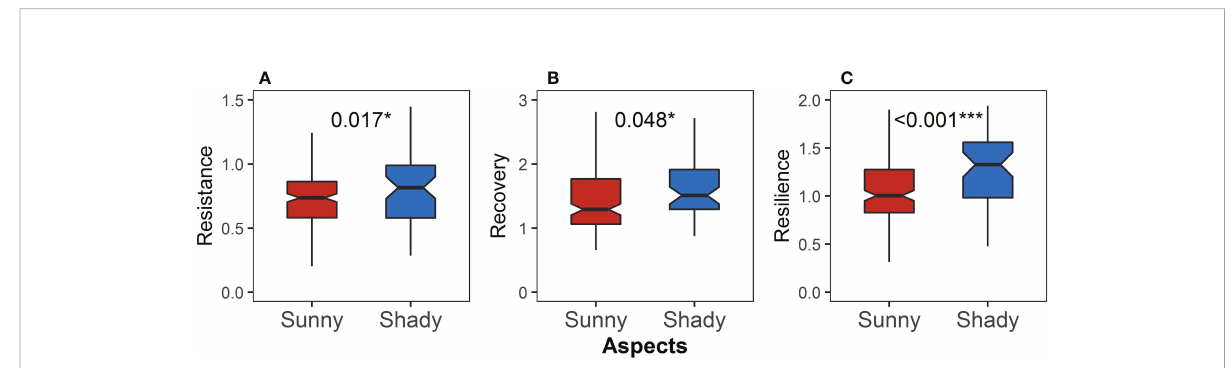
FIGURE 9 Differences in (A) resistance, (B) recovery, and (C) resilience between the sunny and shady slopes. Asterisks indicate signi fi cant differences between the sunny and shady slopes (Kruskal – Wallis rank sum test: *P < 0.05; ***P <